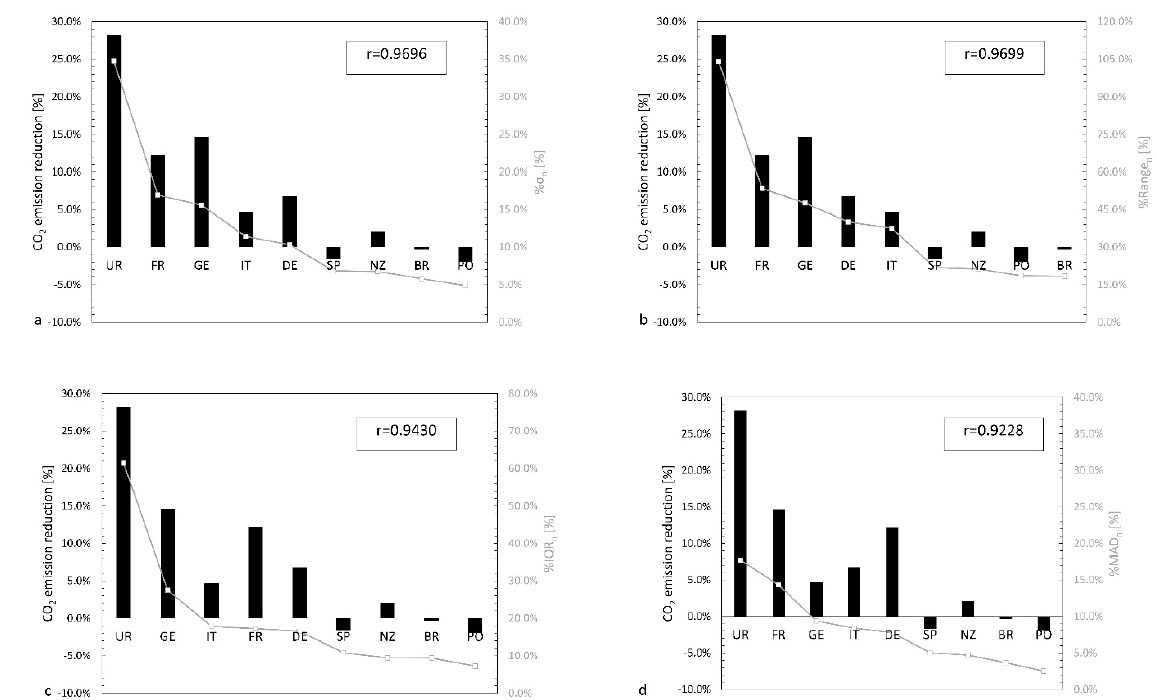
Figure 7. Relations between carbon emission reduction and statistical indexes related to the carbon intensity profiles: ( a ) standard deviation, ( b ) range, ( c ) Inter-Quartile Range, and ( d ) Median Absolute Deviation.